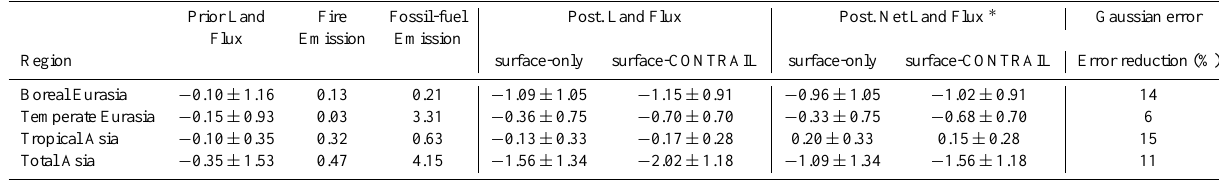
Table 6. The prior/posterior land fluxes, biomass-burning (fire) emissions, fossil fuel emissions and net land flux as well as the Gaussian error/their error reduction rates in surface-only and surface-CONTRAIL inversion experiments during the period 2006–2010 (in PgCyr − 1 ) . Prior